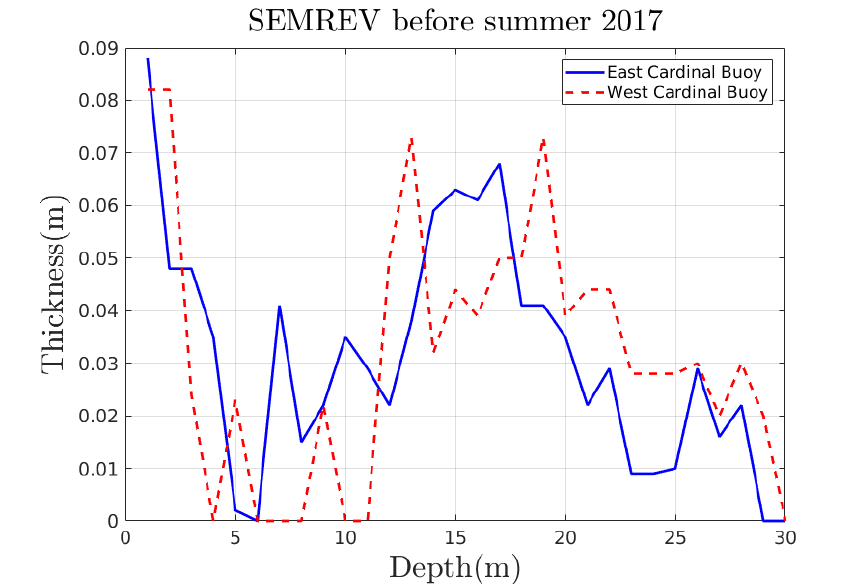
Figure A1. Thickness of mussels colonisation on mooring lines of the SEMREV before summer 2017 [8].